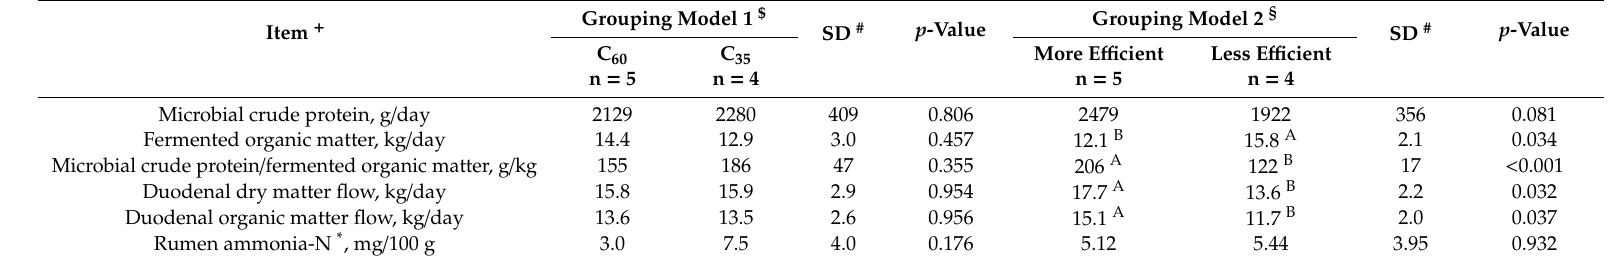
Table 8. E ff ects of concentrate feed proportion in the ration (C) and microbial e ffi ciency (synthesized microbial crude protein / fermented organic matter) on synthesized microbial crude protein (mCP), fermented organic matter (fOM) and microbial e ffi ciency (mCP / fOM), and on duodenal nutrient flows and nitrogen sources, and on ruminal nitrogen balance